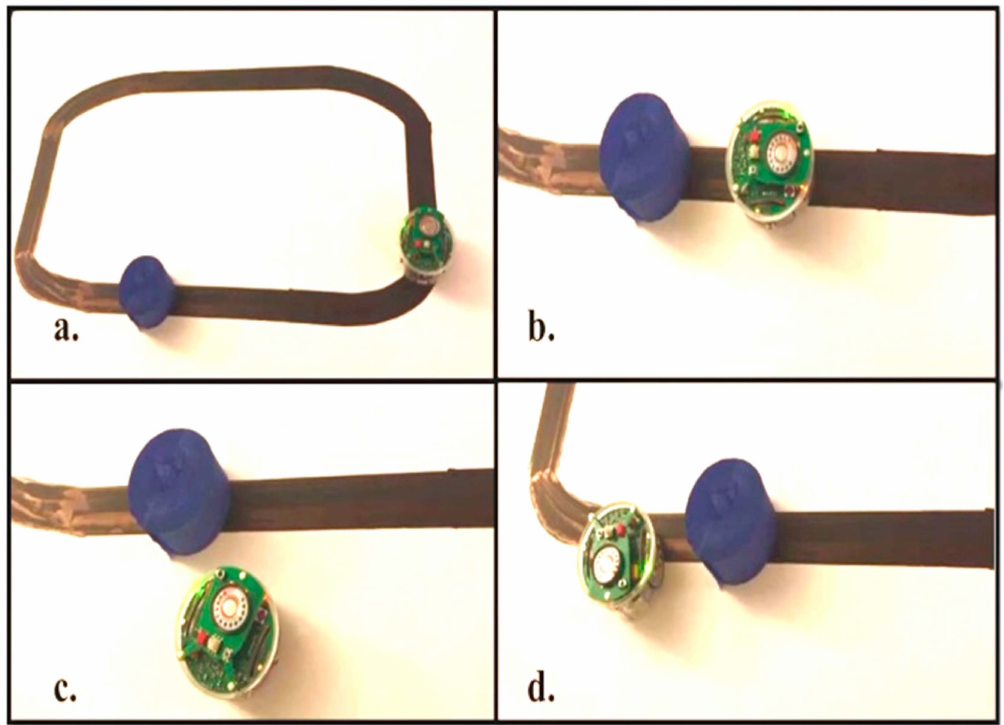
Figure 9. Snapshots of the real time experiment of one robot and one obstacle. ( a ) The beginning of the real time experiment; ( b ) The robot detects an obstacle on its way; ( c ) The robot avoids the obstacle and turns left; ( d ) The robot finds its path again and continues following